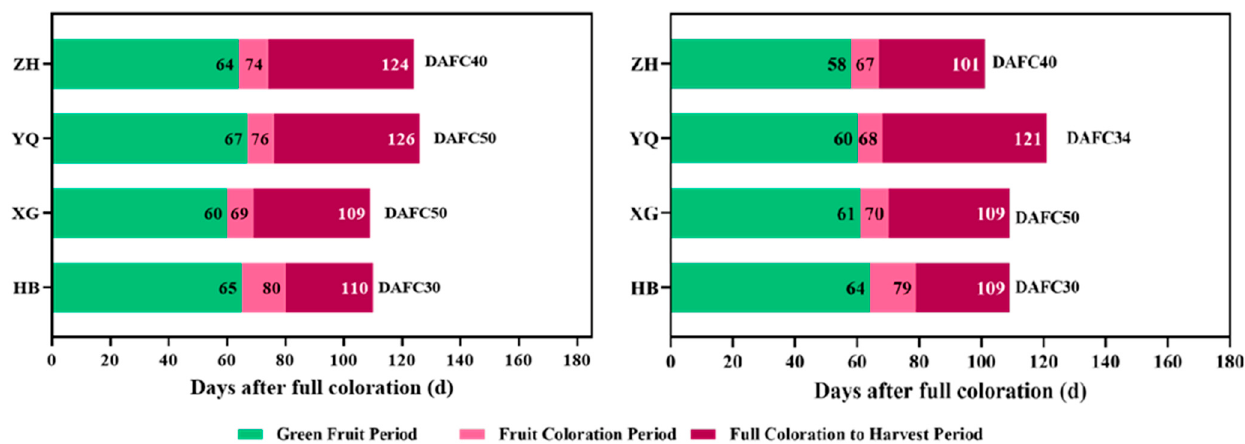
Figure 3. Fruit ripening process of ‘Cabernet sauvignon’ ( left ) and ‘Marselan’ ( right ) in four sub- regions. The numbers in the bars represent days after full flowering at the end of each stage.